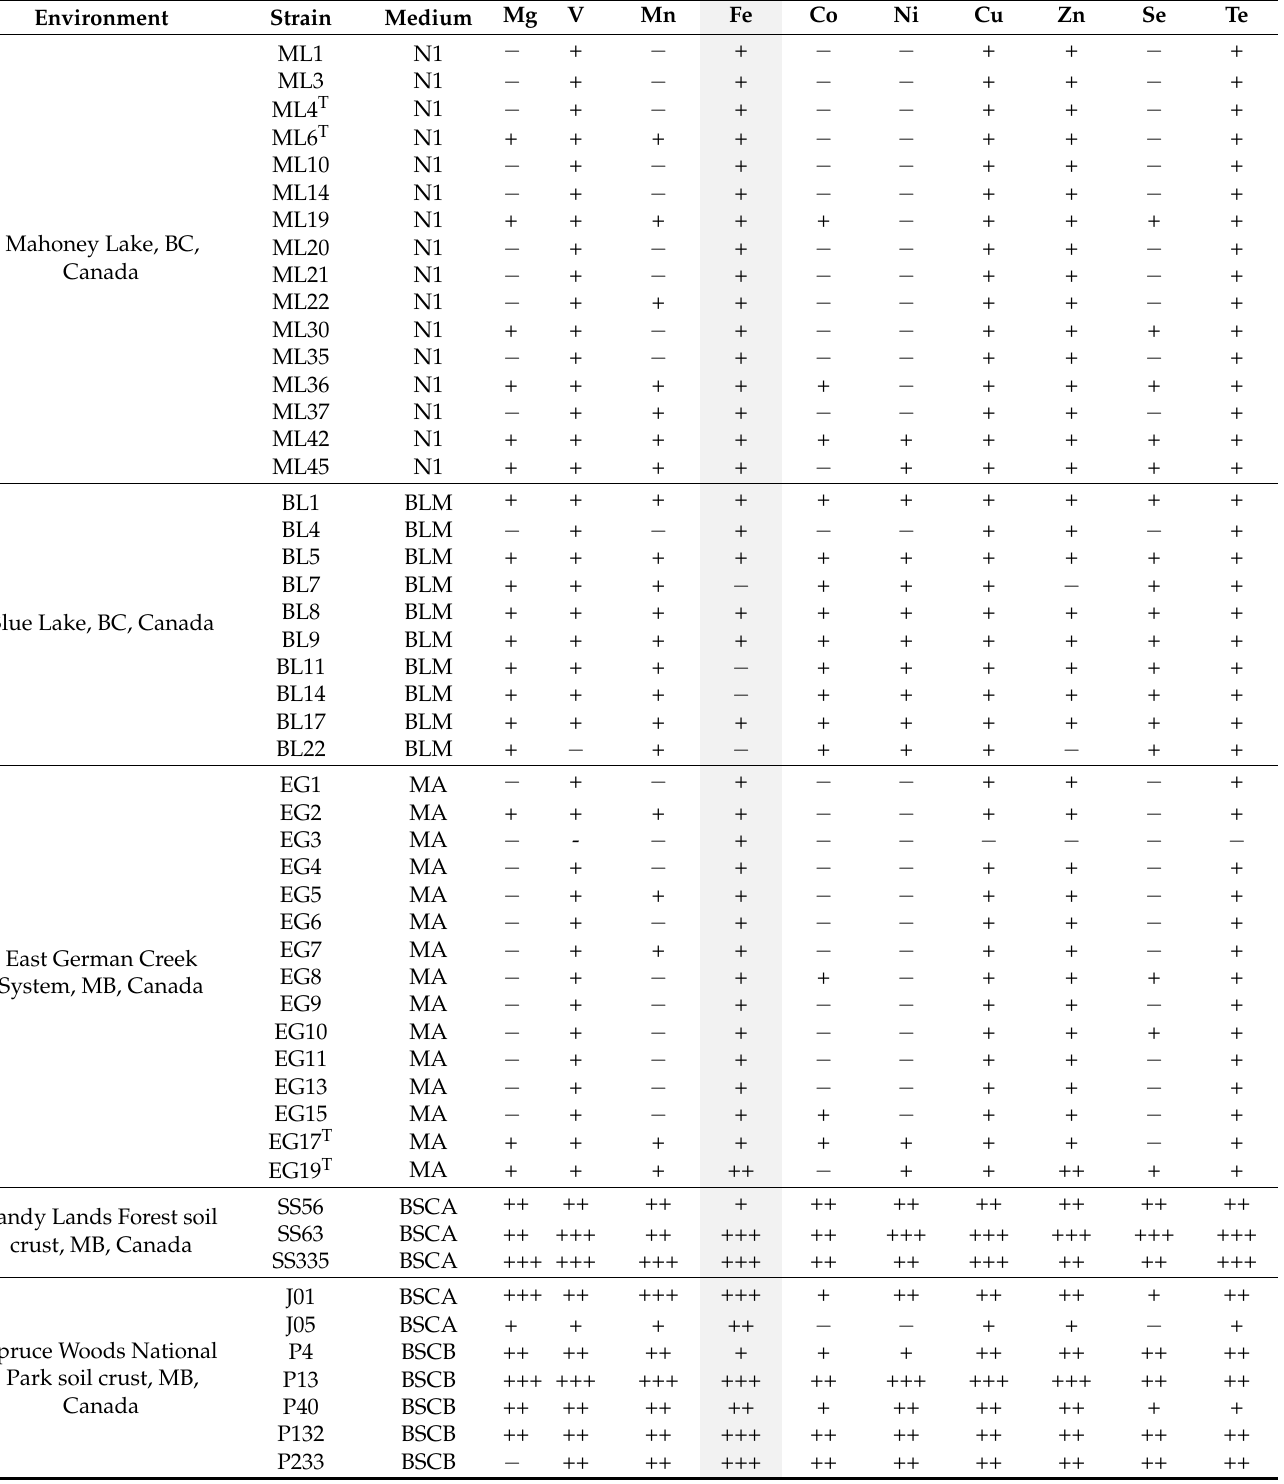
Table 2. Meromictic lake, saline spring and biological soil crust AAP analyzed for metal(oid)-chelation via CAS assays with varied